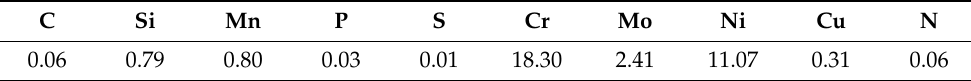
Figure 5. Continuous cooling transformation diagram (CCT) of GX5CrNiMo19-11-2 alloy (ISO 4991:2015) for an austenitizing temperature of 1075 °C, calculated with JMatPro TM v.11.2 software. 3. Results and Discussion 3.1. Characterization of the Initial Powders The characterization of the starting powders was the first step taken to evaluate the morphology and size distribution. The Fe powders are almost round, with an average diameter of 10 µm and a D 50 of 8 µm (Figure 6a,b), unlike the WC powders that show a polyhedral shape (Figure 6c,d). These particles exhibit an average size of 106 µm and a D 50 of 107 µm. The shape of M0101 binder powders is irregular, showing elongated and round particles (Figure 6e,f) with an average size of 475 µm and a D 50 of 398 µm.